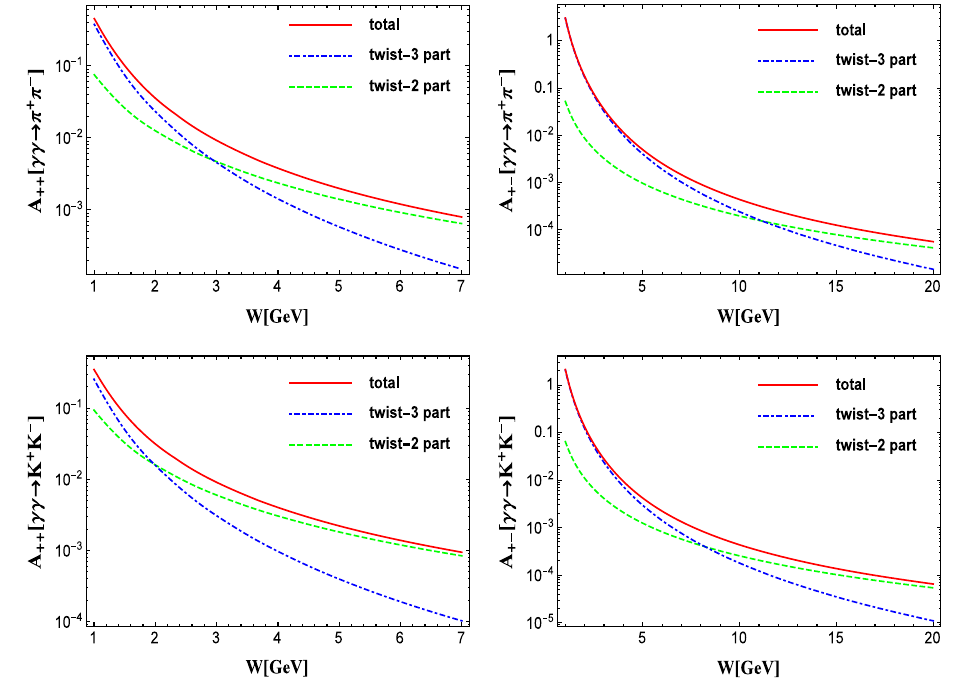
Fig. 3 Dependence of the prediction for γγ → MM transitional matrix element A λ respectively can get μ π for the pion and μ K for the kaon with the = W 2 . The masses of the cur- different energy scale μ 2 R rent quarks are m μ ( 1 GeV ) = m d ( 1 GeV ) = 4 MeV and m s ( 1 GeV ) = 140 MeV [39]. The masses of the pseu- doscalar mesons m π = 139 . 6 MeV and m K = 493 . 7 MeV are quoted from PDG [48]. With the help of Eqs. (36) and (37), we work out 2 . 44 GeV ≤ μ π ≤ 3 . 66